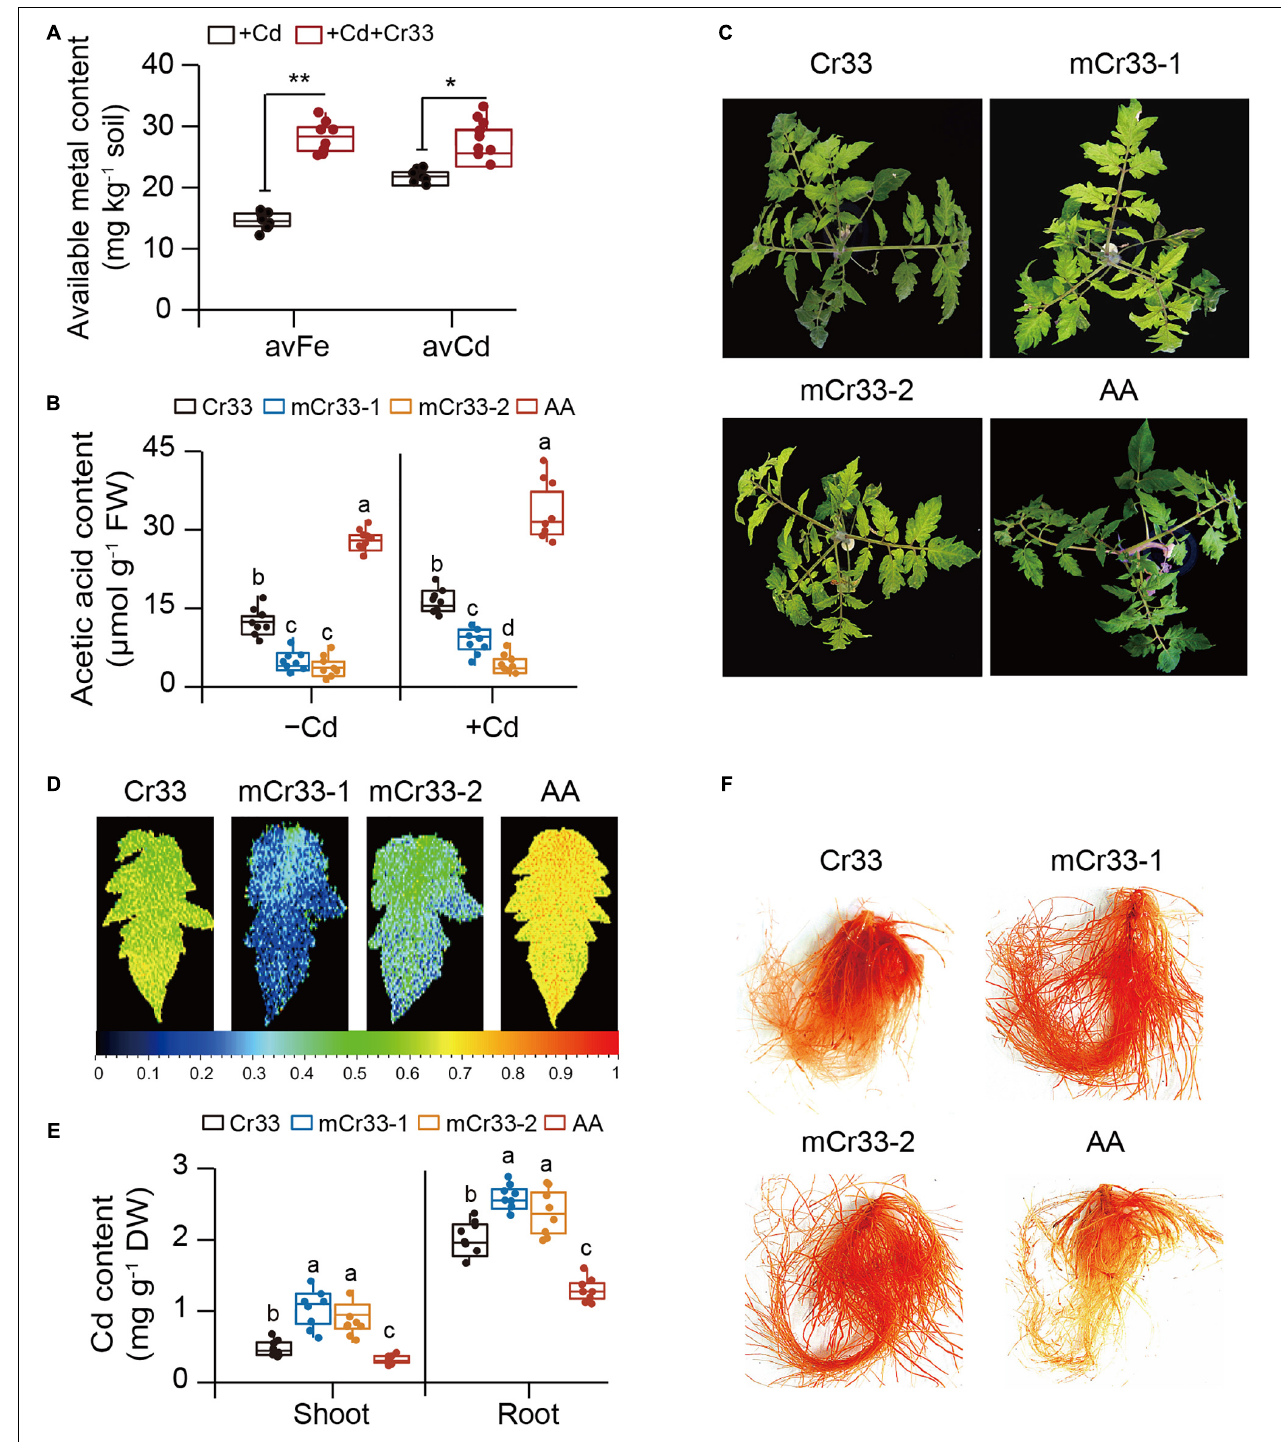
FIGURE 4 | L. fusiformis Cr33-released acetic acid conferred the increased availability of rhizospheric Fe and Cd, and Cd resistance in tomato plants. (A) The bioavailability of rhizospheric Fe and Cd was quantified after 2 weeks of soil drench with Cr33. Asterisks indicated significant differences between the non-inoculated (control) and inoculated plants ( n = 8 biological replicates) using Student’s t -test (* p < 0.05; ** p < 0.01). (B–F) Three-weeks-old tomato plants were cultured in the split-root systems containing 100 µ M Cd with or without Cr33 or its mutant strains (mCr33-1 and -2) for 20 d. These plants were used to analyze root acetic acid content (B) , shoot phenotypes (C) , Fv/Fm images (D) , shoot and root Cd content (E) , and root Cd localization (F) . Different letters indicated significant differences among different experimental groups ( n = 8 biological replicates) using Duncan’s multiple range test at p < 0.05.